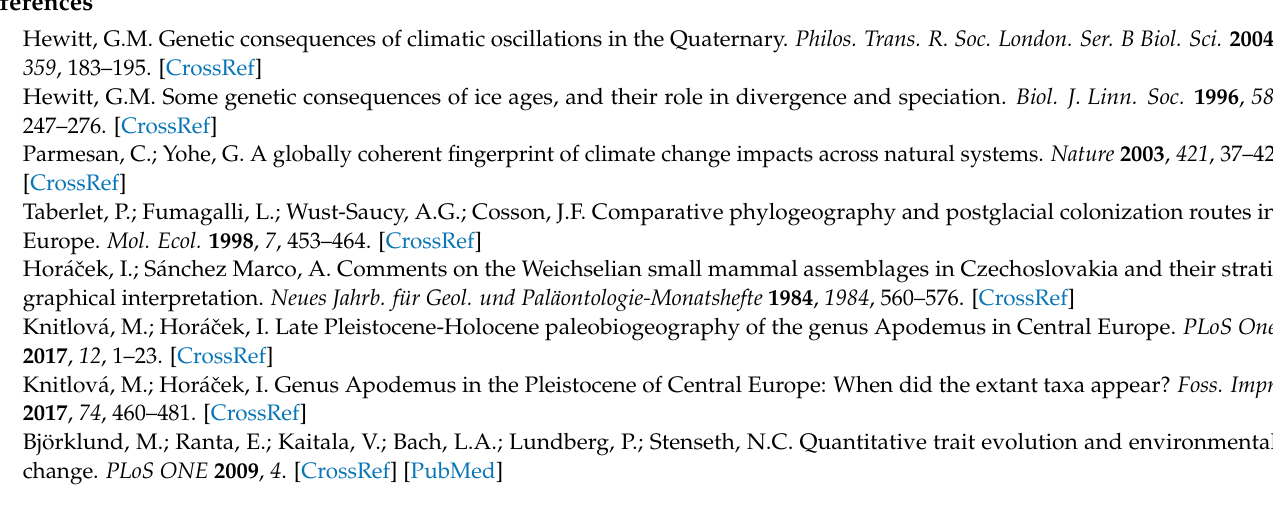
File S4: Table S12. Correlation coefficient between the climatic variables used in MaxEnt analysis; Table S13. Variables used in reconstruction and past environmental niche models of A. agrarius in MaxEnt and percent contribution of variables used in model building; Table S14. Measurement the accuracy of Maxent models of reconstructed predicted present and past distribution range of A. agrarius clades; Figure S3. Predicted current Environmental Niche Models (ENM’s) of distinct clades (C1–C5); Figure S4. Predicted LGM Environmental Niche Models (ENM’s) of distinct clades (C1–C5). In File S5: Figure S5. The range of glacials during the Weichselian and Saalian glaciations and the range of biomes during the Last Glacial Maximum; fossil records of the striped field mouse A. agrarius in the Palearctic. In File S6: Figure S6. The reconstructed sea level changes during the LGM and postglacial period in south-eastern Asia and the formation of the exposed Bohai and Yellow Sea Shelf. In File S7: Figure S7. Postglacial demography trends of the striped field mouse in relation to changes in the area of greatest abundance of the most common European trees and plant